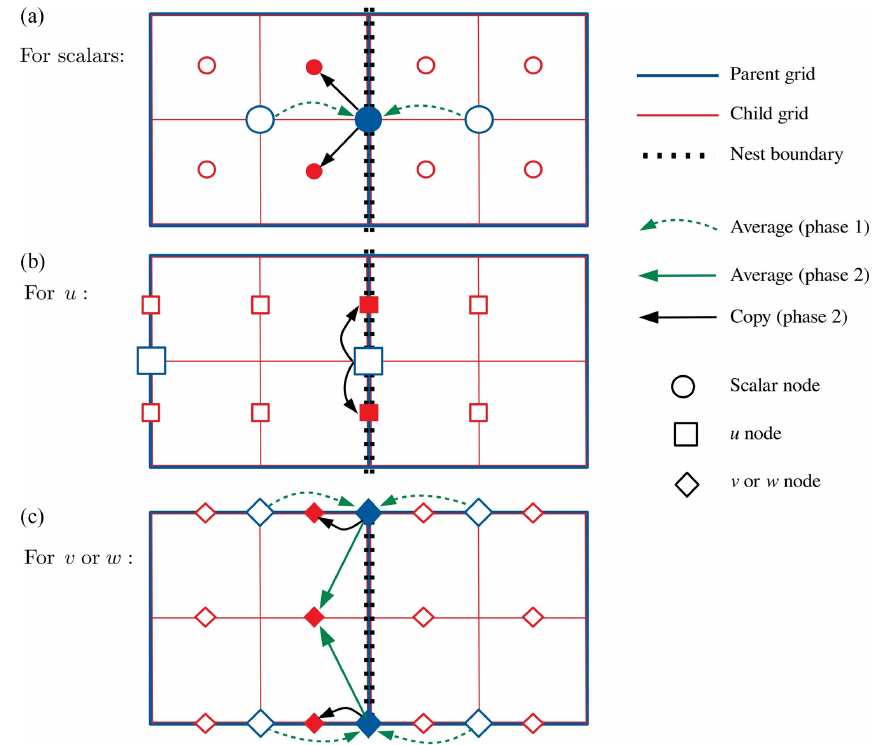
Figure 4. A schematic illustration of the interpolation operations on the left child boundary as an example. The child grid nodes on the left side are boundary ghost nodes. Phase 1 operations belong to the TBP, and phase 2 operations belong to the actual parent-to-child interpolation using Eqs. (8) and (9). Filled blue symbols denote intermediate values on the boundary plane (flux plane) resulting from the TBP. Filled red symbols denote the final boundary condition values for the child boundary. In this example, u is u (N) , while v and w are u (S)